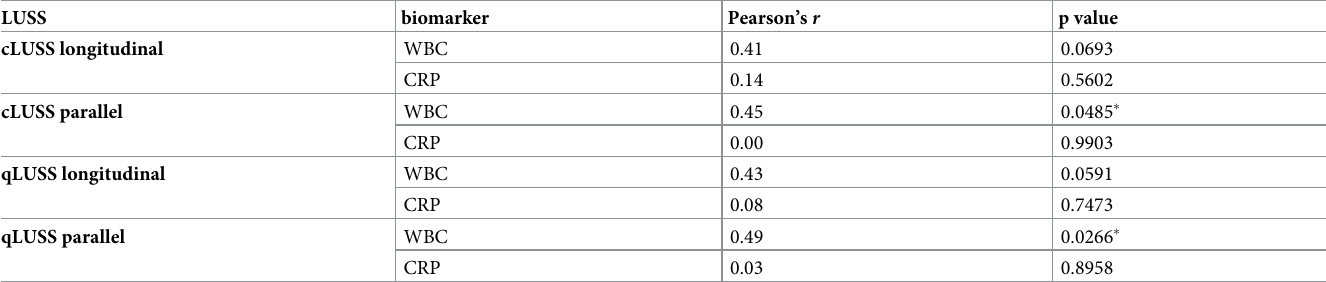
Table 6. Correlation of biomarkers with